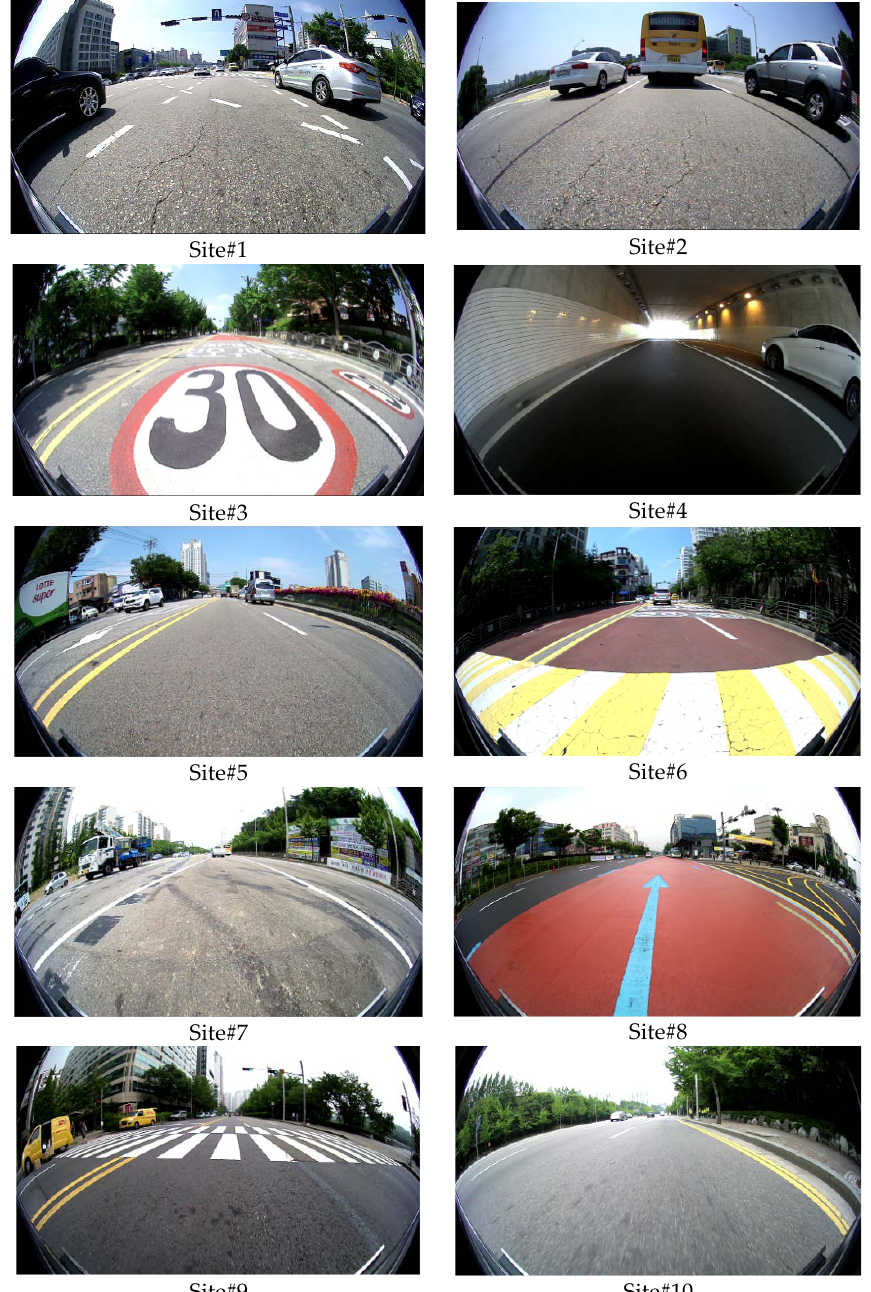
Figure 12. Example images of the test dataset taken at 10 different sites.